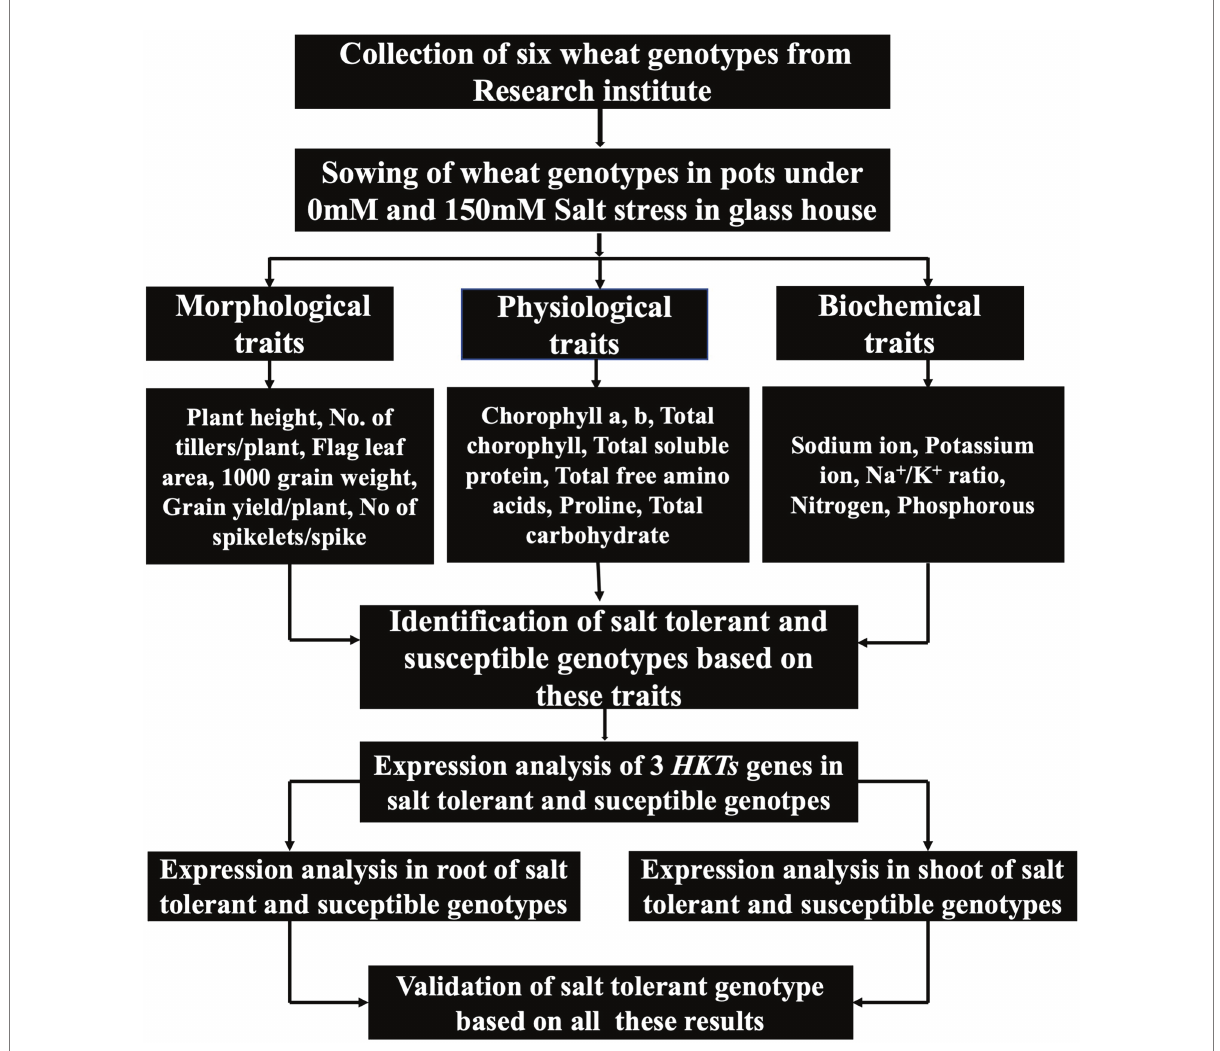
FIGURE 1 A schematic diagram of research